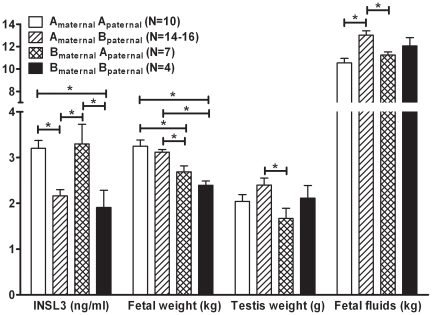
INSL3 concentration in fetal venous blood, fetal weight, fetal testis weight, and calculated total fetal fluids on day 153 of pregnancy, and sorted by fetal genetics, as indicated.Amaternal indicates an Angus (B. taurus) dam, Bpaternal a Brahman (B. indicus) sire, etc.